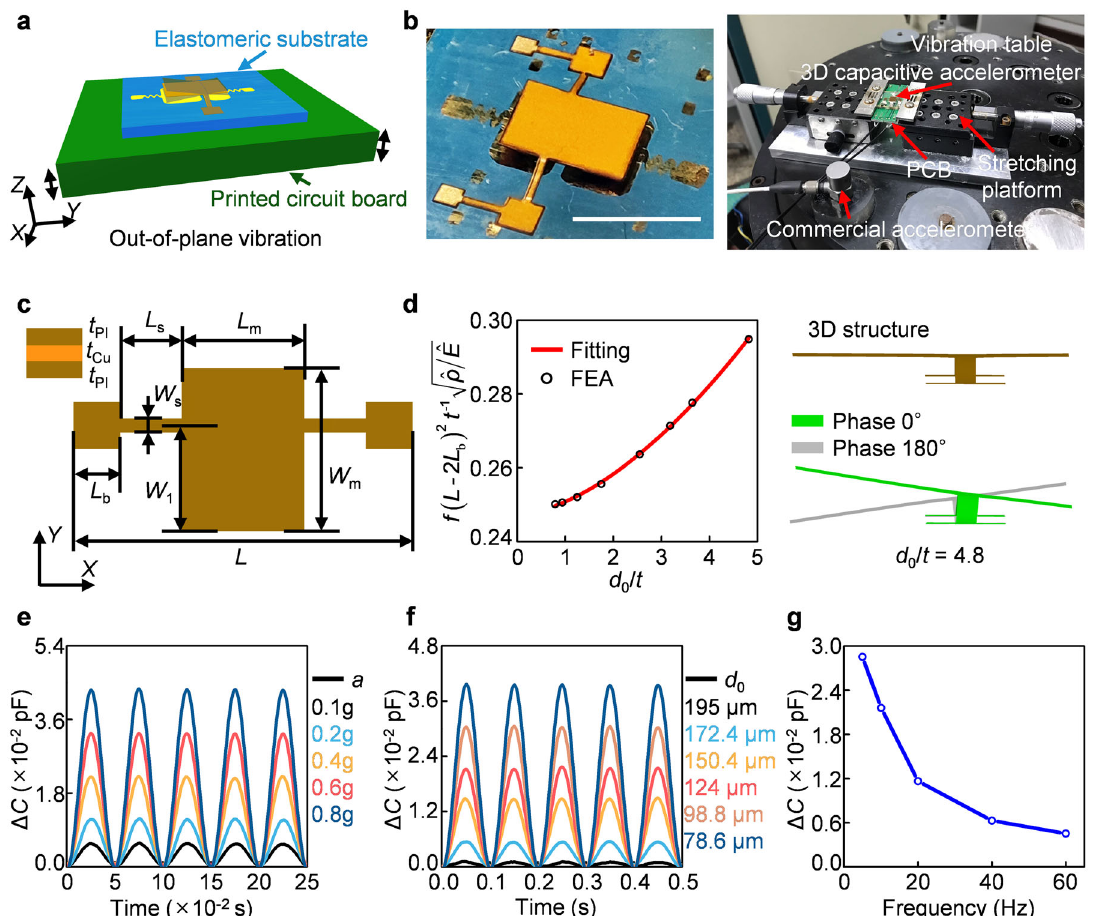
Fig. 4 Acceleration sensing with a tunable sensitivity. a Measurement schematic of 3D capacitive accelerometer. b Optical image of 3D capacitive accelerometer with the applied strain ( ε appl = 0%) as shown in the left panel. The right panel shows the vibration test system. c Schematic illustration of geometric parameters of the 3D capacitive accelerometer with an asymmetric design. d The dimensionless ffiffiffiffiffiffiffiffi q ^ ρ = ^ E Þ as a function of dimensionless gap ( d resonant frequency ð f ð L (cid:2) 2 L b Þ 2 t (cid:2) 1 0 / t ). The left panel shows the 3D mesostructure and out-of- plane vibration modes, corresponding to the largest amplitudes during vibration, i.e., green: phase 0°, gray: phase 180°. e Dynamic measurements of the 3D capacitive accelerometer with different levels of acceleration amplitude under a vibration frequency (20 Hz) and an initial gap (124 μ m). f Dynamic measurements of the 3D capacitive accelerometer with different initial gaps under a vibration signal (0.2 g, 10 Hz). g Dynamic measurements of the 3D capacitive accelerometer with different excitation frequencies under an acceleration amplitude (0.2 g) and an initial gap (124 μ m). Scale bar, 4 comparison among the developed 3D capacitive sensor, the MEMS differential capacitance force sensor 69 , and the commercial force sensor (FT-S100) 69 . The commercial force sensor adopts a comb-